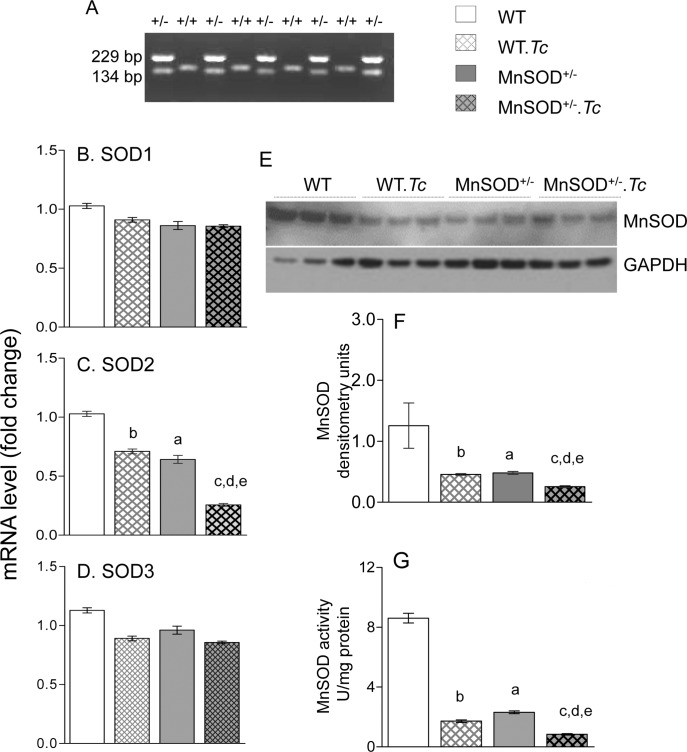
Expression and activity of superoxide dismutases in chagasic mice.C57BL/6 (WT and MnSOD+/-) mice were infected with Trypanosoma cruzi (10,000 Tc/mouse), and sacrificed at 150 days’ post-infection (pi) corresponding to chronic disease phase. (A) Total DNA was used as template for genotyping the MnSOD+/- (vs. WT) mice. The amplification of a 229 bp band indicates the integration of xx within MnSOD gene (B-D) Reverse transcription—quantitative PCR (RT-qPCR) evaluation of myocardial levels of SOD1
(B), SOD2
(C)
and SOD3
(D) mRNAs was performed in WT and MnSOD+/- mice before infection and at 150 days pi. The data were normalized to GAPDH mRNA (n = 6 mice per group, triplicate observations per mouse). (E&F) Representative Western blot images for myocardial levels of MnSOD and GAPDH (loading control) are shown (E, n = 3 mice per group). Densitometry analysis was performed for Western blot gels representing n = 6 mice per group (duplicate observations per mouse), and data were normalized to GAPDH levels (F). (G) Heart homogenates were subjected to differential centrifugation to isolate mitochondria. Mitochondrial MnSOD activity was determined by a spectrophotometric assay (n = 6 mice per group, duplicate observations per mouse). Data in bar graphs are plotted as mean value ± SEM. Statistical significance are marked as aMnSOD+/- vs. WT, bWT.Tc vs. WT, cMnSOD+/-.Tc vs. MnSOD+/-, dMnSOD+/-.Tc vs. WT.Tc, and eMnSOD+/-.Tc vs. WT (p value < 0.05).